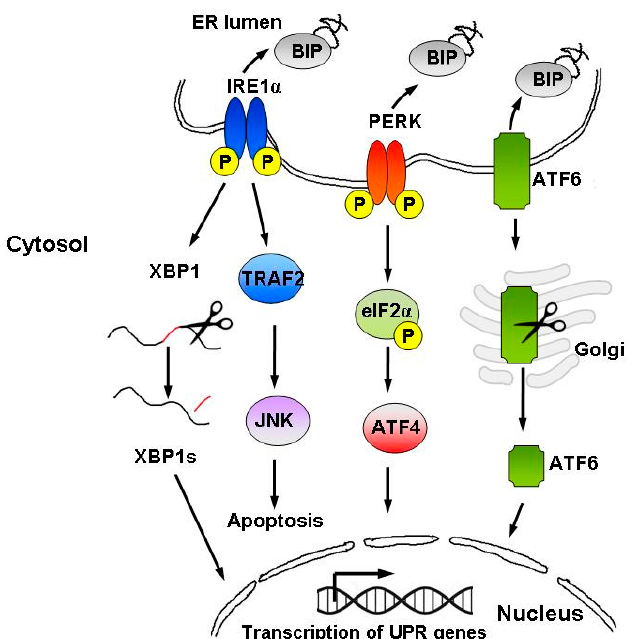
Figure 2. Schematic representation of the UPR signaling pathways. The UPR is activated by accumulation of unfolded proteins in the ER lumen, followed by BiP dissociation from the three ER stress sensors, i.e., IRE1 α , PERK, and ATF6. The UPR instigates a transcriptional and translational response to ER stress in order to restore protein homeostasis. However, upon persistent ER stress, pro-apoptotic signaling is induced and the cell undergoes programmed cell death.